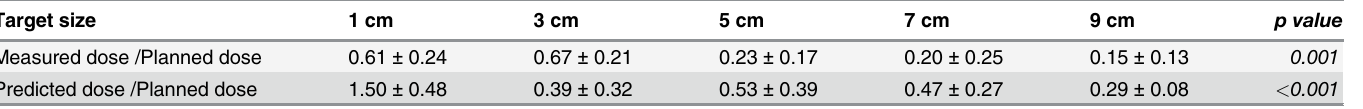
Table 2. Comparison of dose deviations (%) among treatment planning system (TPS)-planned dose, ion-chamber measured isocenter dose, and the 3DVH-predicted isocenter